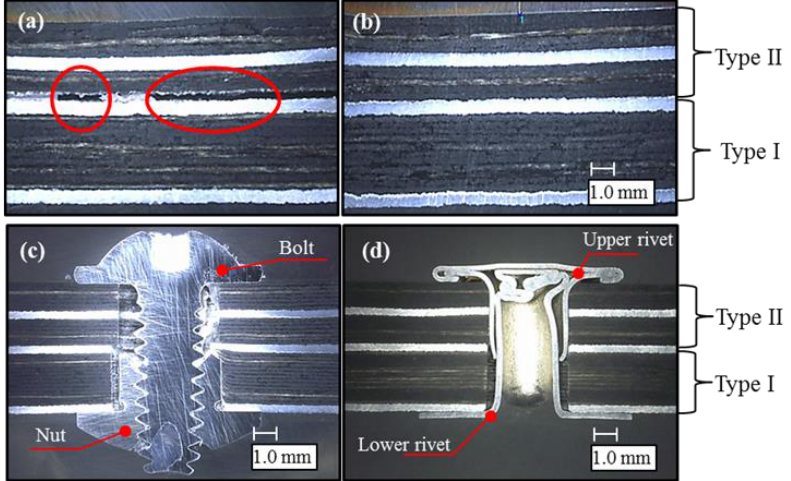
Figure 9. Type I+II cross sectional views of ICJ samples that ( a ) failed and ( b ) succeeded, and ( c ) NB and ( d ) 2PR mechanical joining processes.